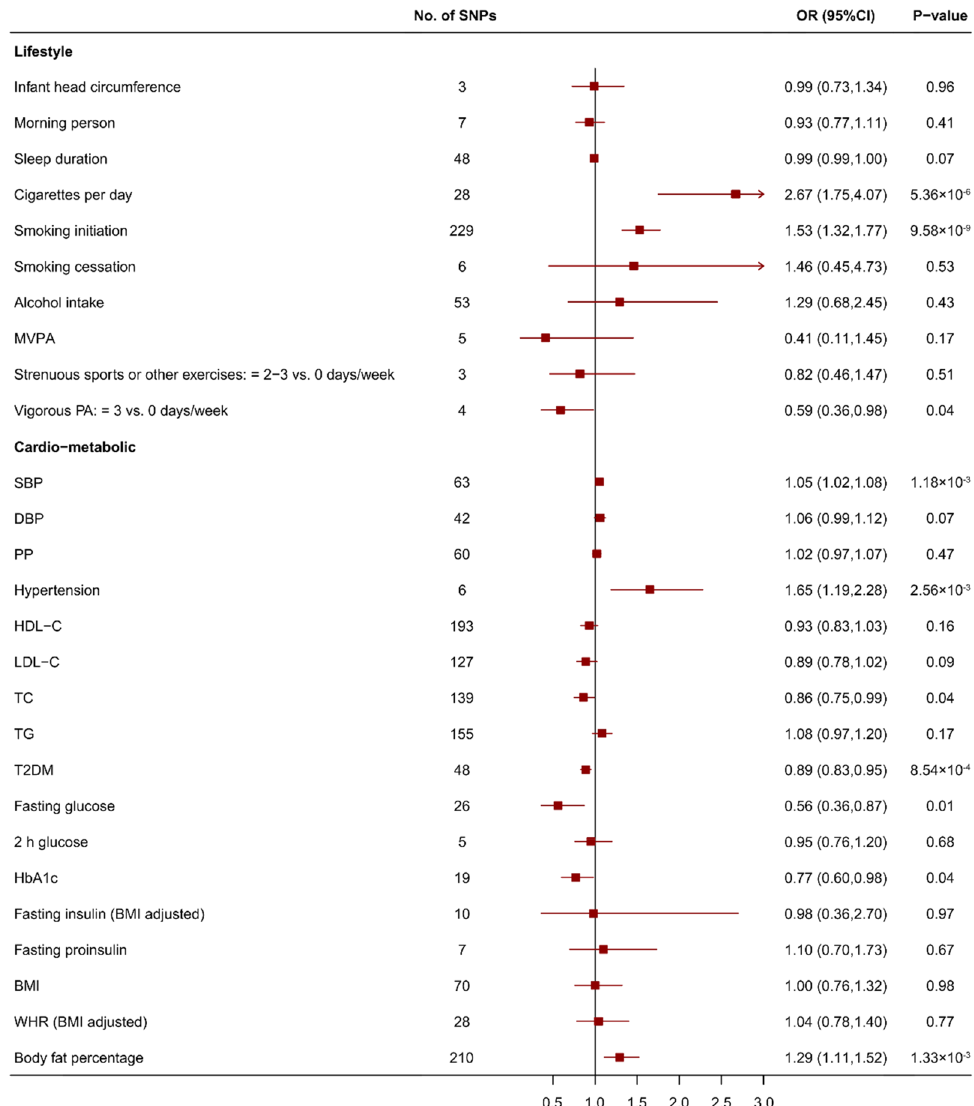
Figure 2. Mendelian randomization for associations between traits of lifestyle and cardio-metabolic risk factors and intracranial aneurysm. SNP: single nucleotide polymorphism; OR: odds ratios; CI: confidence interval; BMI: body mass index; MVPA: moderate-to-vigorous physical activity; SBP: systolic blood pressure; DBP: diastolic blood pressure; PP: pulse pressure; HDL-C: high-density lipoprotein cholesterol; LDL-C: low- density lipoprotein cholesterol; TC: total cholesterol; TG: triglyceride; T2DM: type 2 diabetes mellitus; HbA1c: hemoglobin A1c; WHR: waist hip